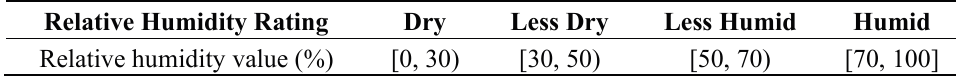
Table 3. Fuzzy classification of relative humidity.